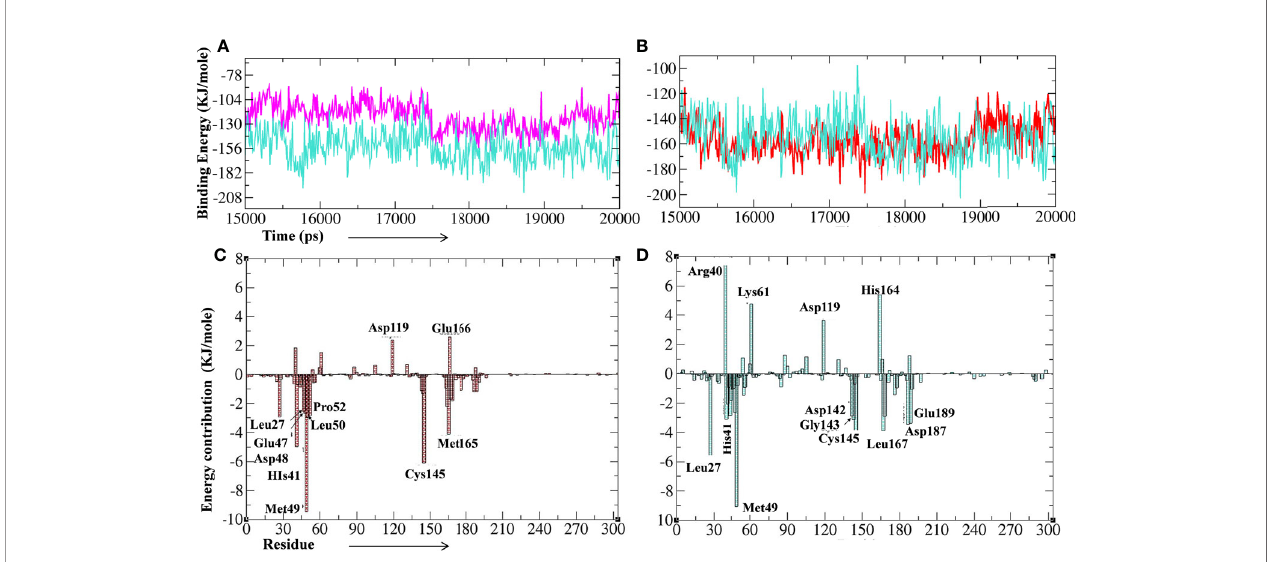
FIGURE 10 | Binding energy of the lead phytochemicals and contribution energy of amino acid residues in the g_mmpbsa analysis. (A) Binding energy plot of M pro - lopinavir (light-blue color) and 10-Hydroxyaloin A (pink color) complex. (B) Binding energy plot of M pro -lopinavir (light-blue color) and Isoquercetin (red color) complex. (C) Residue contribution plot of M pro -10-Hydroxyaloin A complex. (D) Residue contribution plot of M pro - Isoquercetin